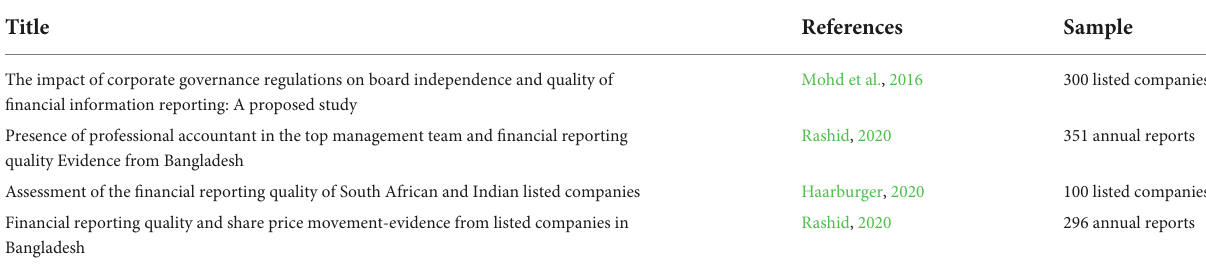
FIGURE2 Bibliometric analysis of co-authorship, based on VOSViewer.